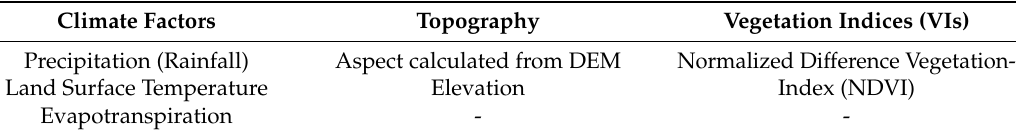
Table 1. Factors and vegetation index considered in this